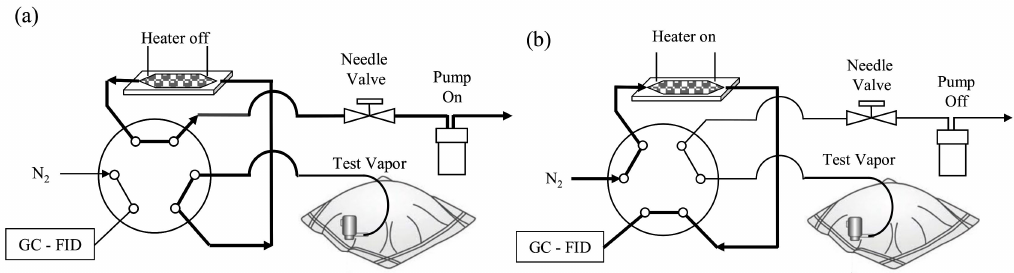
Figure 3. Organic vapor sampling and injection experiment setup: ( a ) sample loading; ( b ) sample injection (i.e., thermal